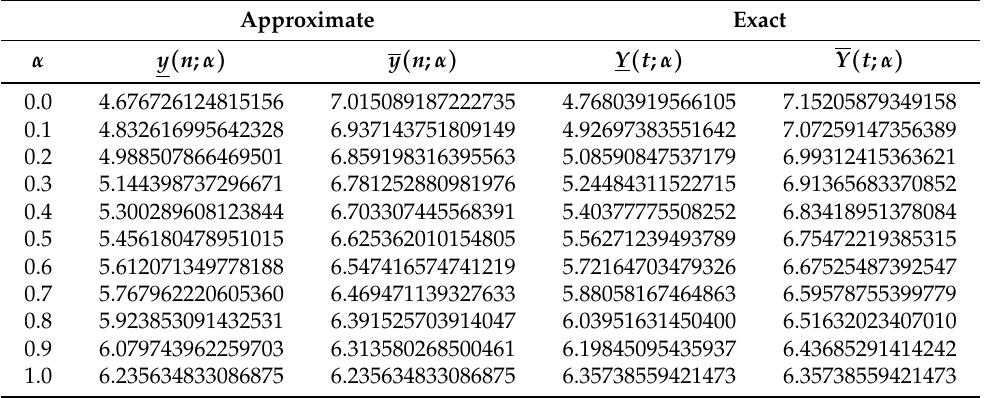
Table 2. Values of exact and approximate solutions by using the Euler method for the indicated